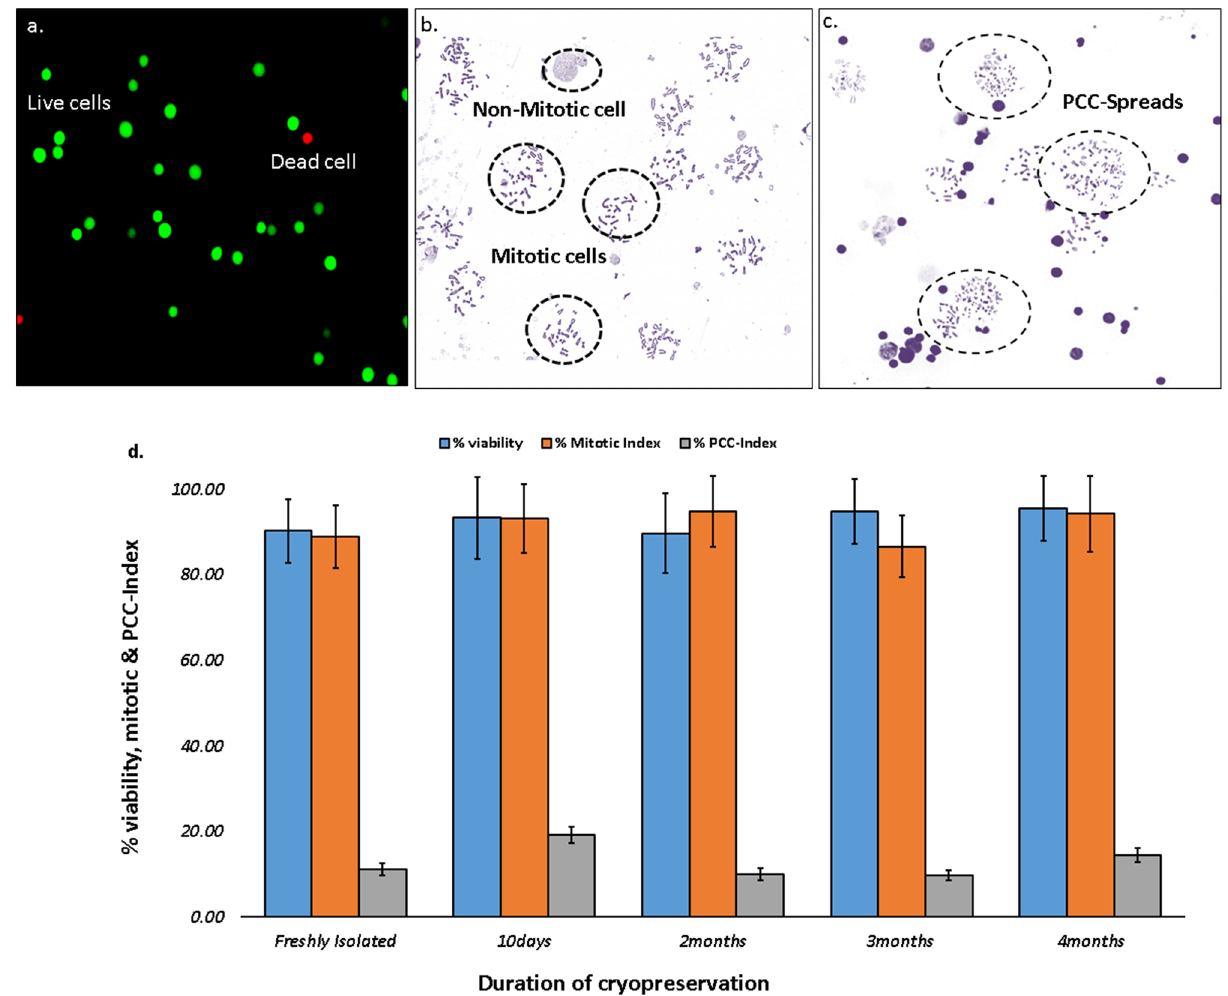
Figure 3. Evaluation checkpoints of cryopreservation mitotic cells for PCC ( a ) Viability; Mitotic cells after differential staining of live dead cells ( b ) Mitotic index; Chromosomal spreads from mitotic cells in a microscopic view. Each chromosome spread represents one mitotic cell (encircled) and nuclei which did not form spread counted as non-mitotic cells. ( c ) Fusion/PCC index Chromosomal spread preparation on slide after cell fusion induced PCC. PCC spreads can be identified by presence of both metaphase chromosomes from mitotic cell and prematurely condensed chromosomes from lymphocytes (encircled). ( d ) Viability, mitotic index and PCC index of mitotic cells after variable duration of cryopreservation. (Error bar represents 1.96xSE of